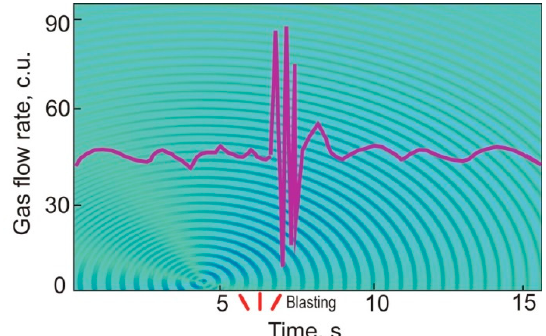
Figure 8. Generalized pattern of FG release into sealed shot-holes in response to blasting (from [88], with modifications). Gas discharges were recorded in 12 cases using a rotameter. The conventional moment of blasting at a distant section of the mine is shown under the horizontal axis at an arbitrary time. C.u.—conventional units.